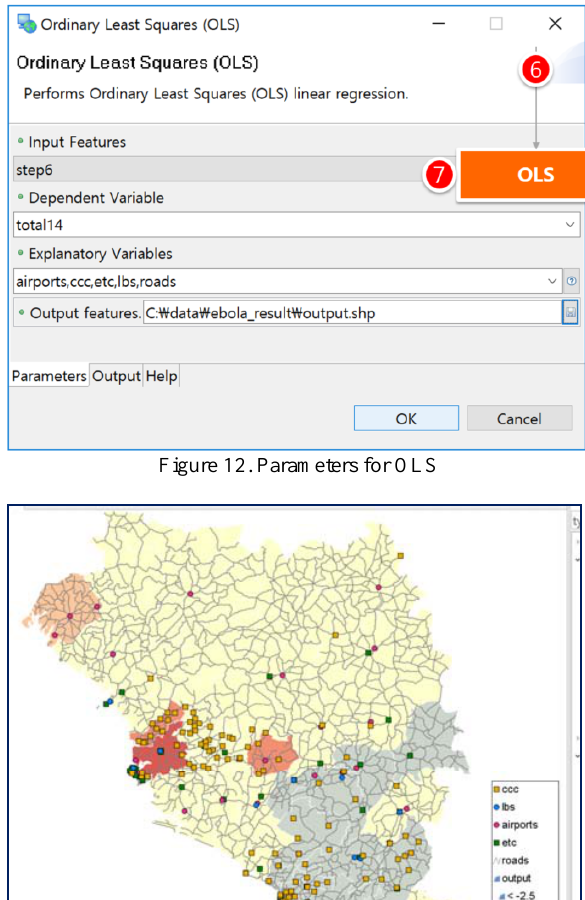
Figure 13. Output of OLS: districts re-classified with residual standard